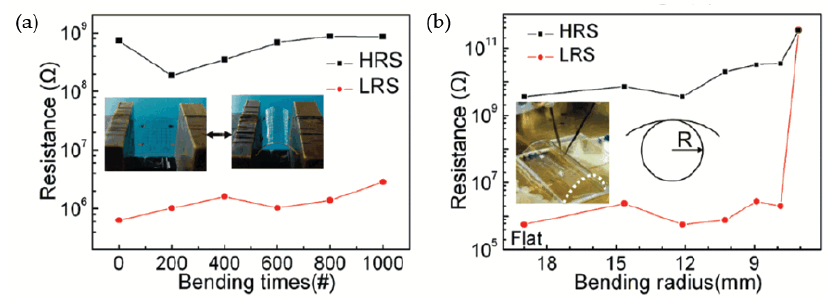
Figure 12. Measurement of bending effect for Al/GO/Al/PES RRAM devices. ( a ) The relationship between on/off ratio and bending times and ( b ) the relationship between on/off ratio and bending radius [124] .